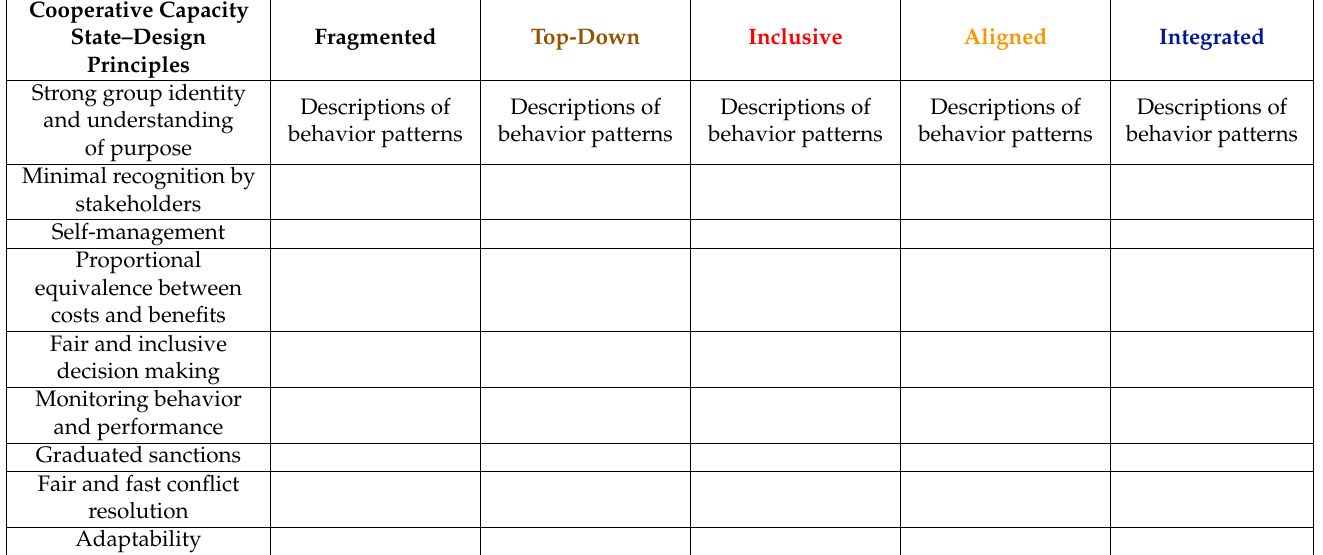
Table 4. The Partnership Maturity